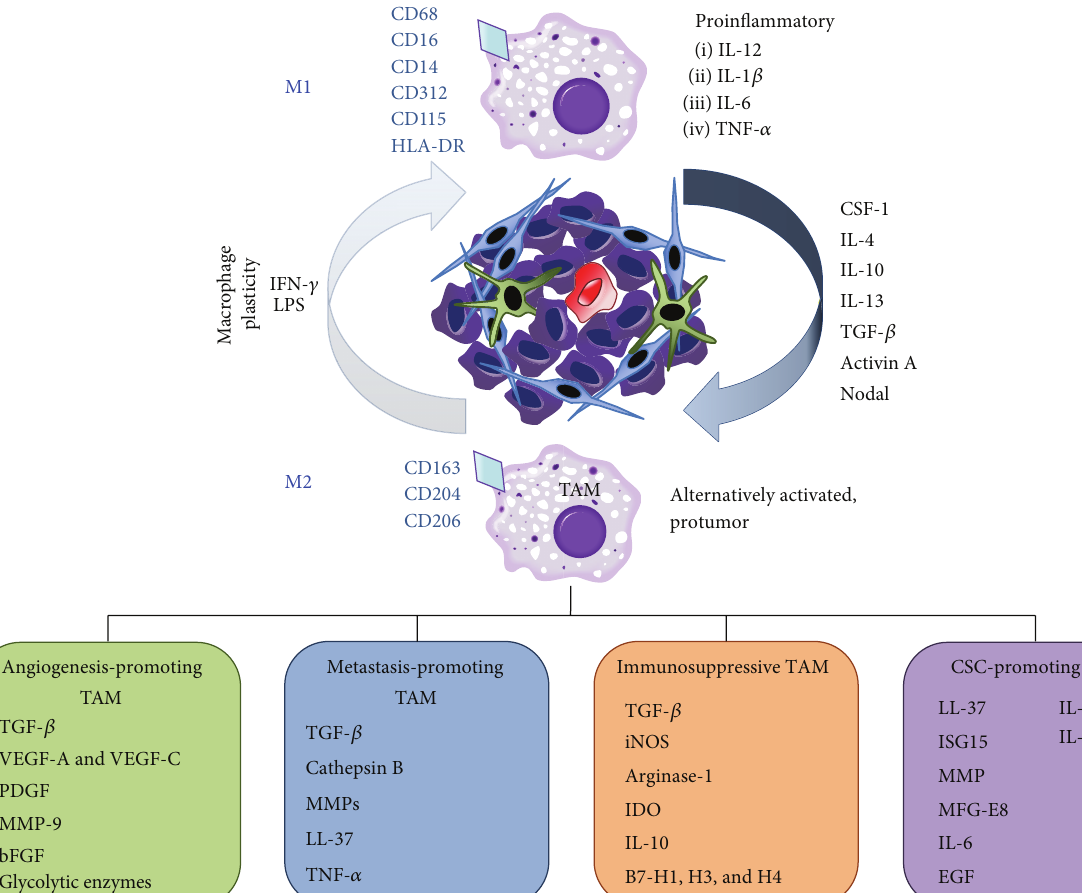
Figure 3: Macrophage plasticity and characterization. The binary M1/M2 classification of macrophages suggests that human macrophages exist as either proinflammatory M1 macrophages or protumor M2 TAMs, which can be identified based on the expression of cell surface cell membrane markers. This concept has been challenged by the identification of numerous TAM subtypes (angiogenesis-promoting TAM, metastasis-promoting TAM, immunosuppressive TAM, and CSC-promoting TAM) that exist within the primary tumor and metastatic sites. The existence of a specific TAM subtype is driven by the interaction of macrophages with factors secreted by the tumor microenvironment, leading to transcriptional rewiring of TAMs with a specific gene signature profile. TAMs are highly plastic and can shift between subtypes based on tumor-specific signals and